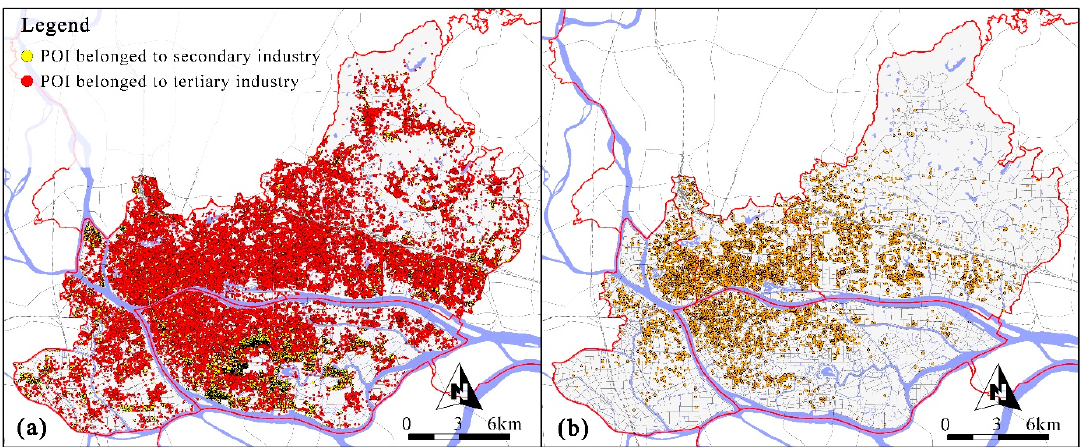
Figure 2. Data distribution of ( a ) points of interest (POIs) and ( b ) residential buildings.